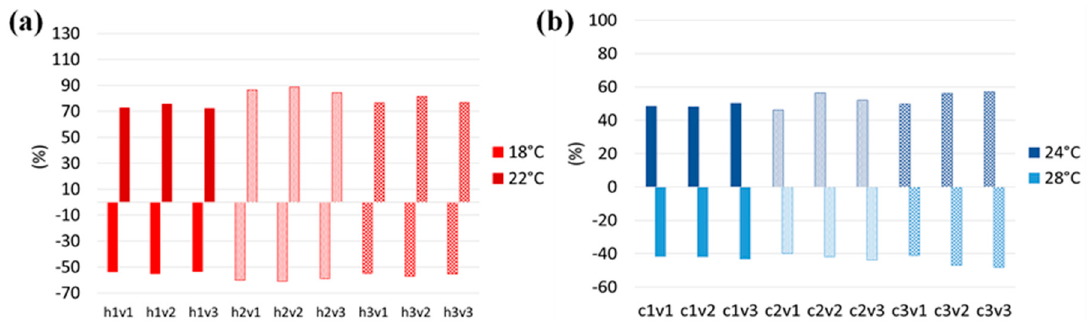
Figure 10. Relative differences of the ( a ) heating and ( b ) cooling energy needs caused by a variation of the setpoint temperature of ±2 °C in 2050.